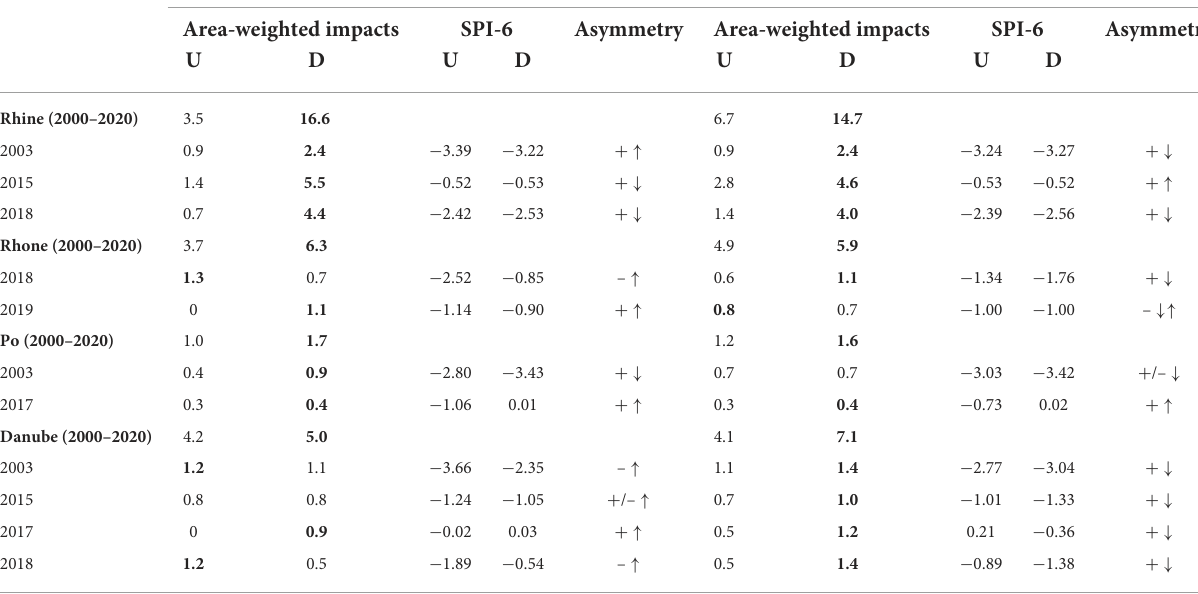
TABLE 1 Number of impacts · 10 − 3 /km 2 and drought indices in the basin-specific drought years; + ↓ : more impacts D, stronger drought hazard D, + ↑ : more impacts D, stronger drought hazard U, – ↓ : more impacts U, stronger drought hazard D, – ↑ : more impacts U, stronger drought hazard U. Distance classification Human footprint